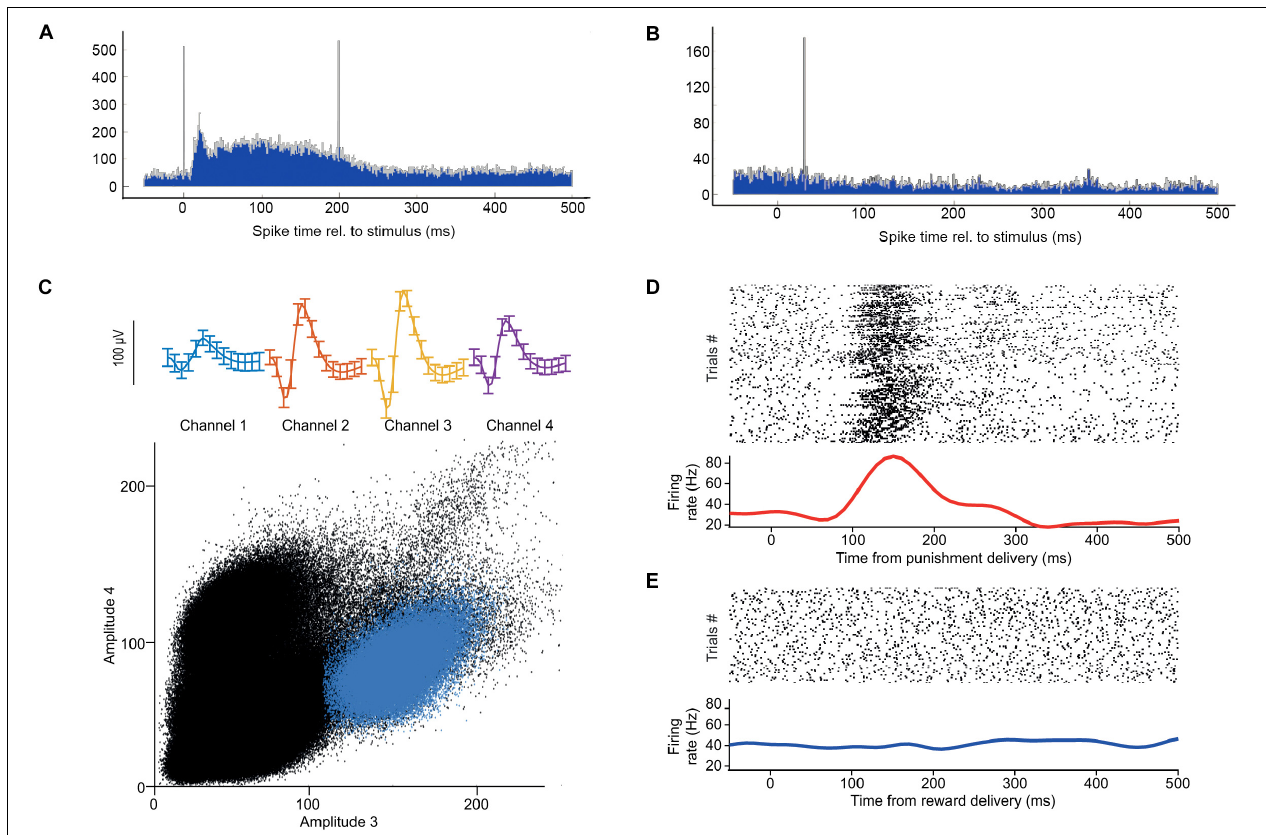
FIGURE 8 | Neuronal responses to behaviorally relevant events detected real-time by OPETH. (A) OPETH online histogram aligned to delivery times of negative behavioral feedback (punishment). OPETH indicated an increase in neuronal activity in response to punishment delivery (vertical lines indicate artifacts due to valve opening and closing). (B) OPETH online histogram aligned to delivery times of positive behavioral feedback (reward). No neuronal response was detected after reward delivery. (C) After offline analysis, punishment-responsive neurons were detected on the tetrodes indicated online by OPETH. The plot shows spike shape (top) and cluster projection (bottom) of an example punishment-activated reward-unresponsive neuron after offline spike sorting. (D) Spike raster and PETH aligned to the onset of punishment delivery for the same neuron. (E) Spike raster and PETH aligned to the onset of reward delivery for the same